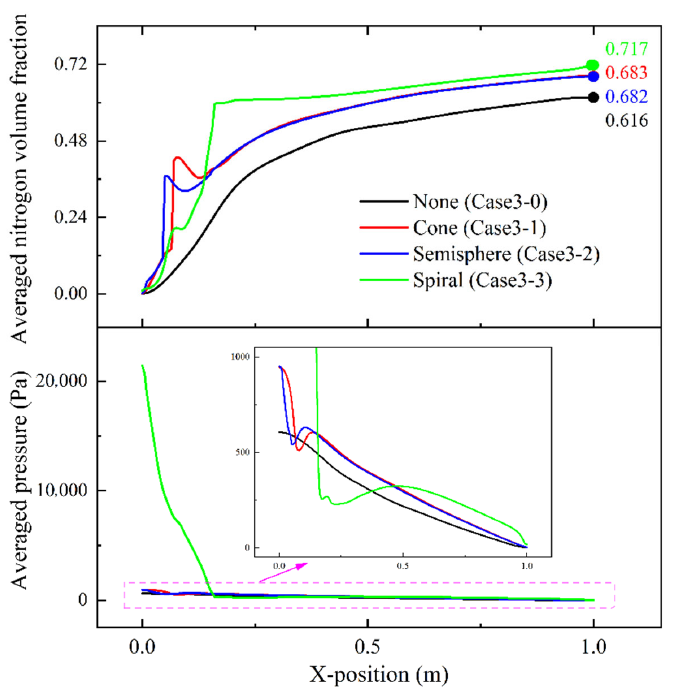
Figure 10. The N 2 volume fraction and pressure of cross sections at X-positions with different-shaped spoilers.